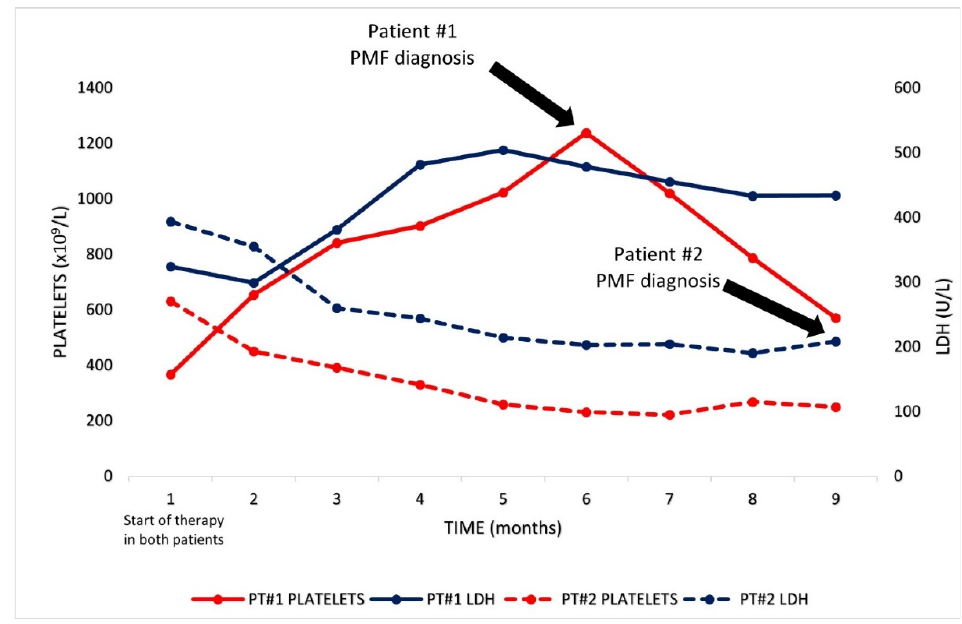
Figure 2. Graphical representation of platelets and LDH levels of both patients from the start of therapy with either ibrutinib or venetoclax until PMF diagnosis.